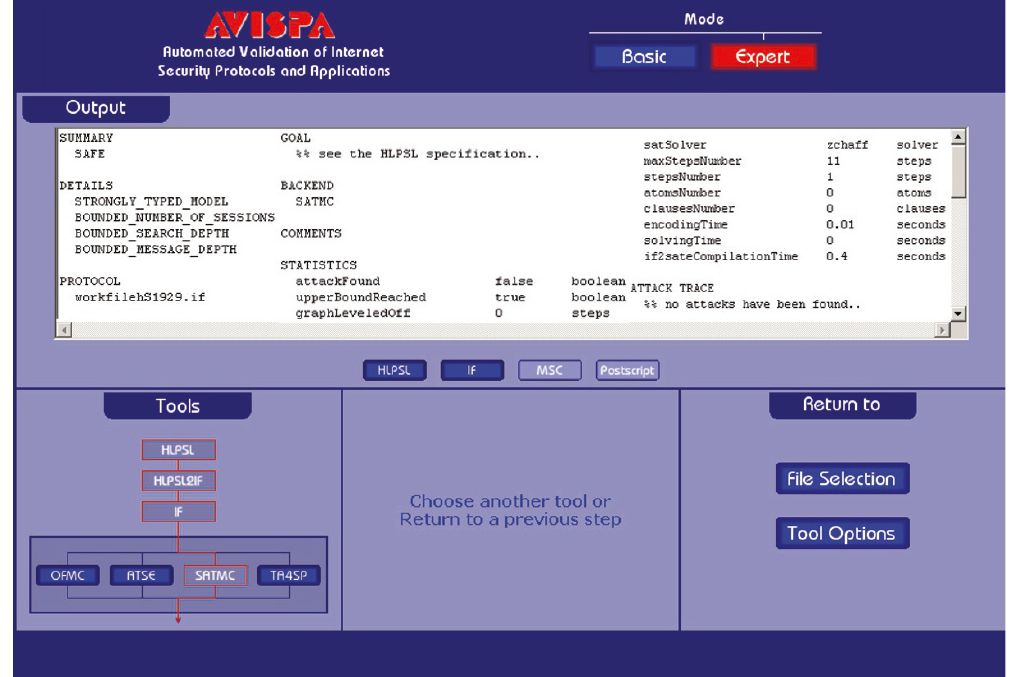
Figure 16: Message returned by AVISPA web interface after testing Intra-WLAN FP with